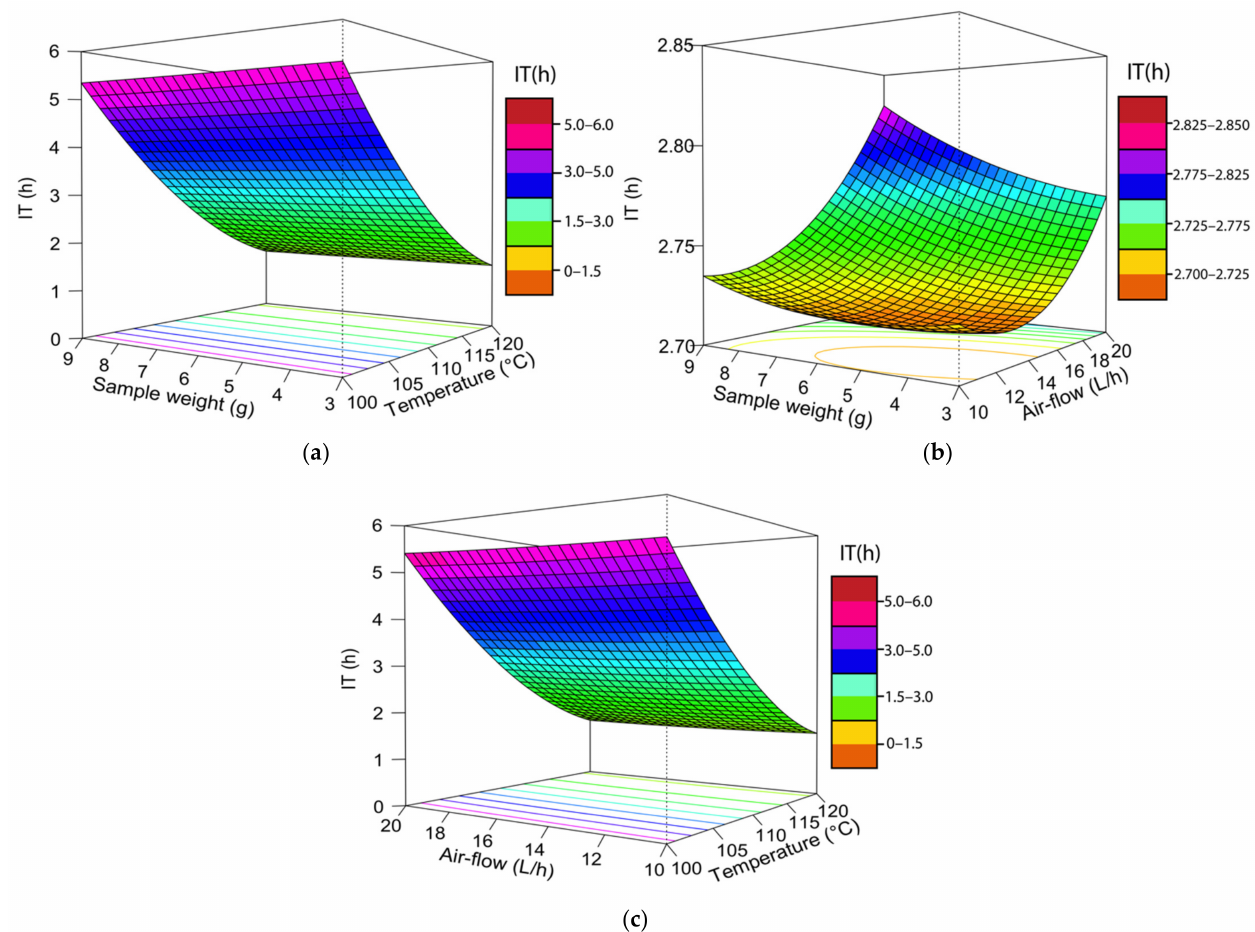
Figure 3. Surface and contour plots for the induction time ( IT -h) versus ( a ) sample weight (g) and temperature ( ◦ C), ( b ) sample weight (g) and airflow (L · h − 1 ), and ( c ) air-flow and